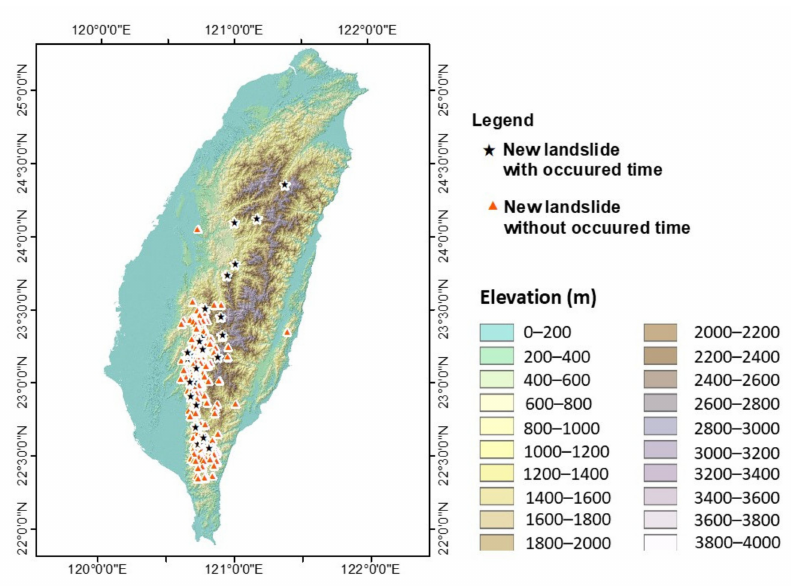
Figure 8. Spatial distribution of new landslide cases for the occurrence rainfall threshold